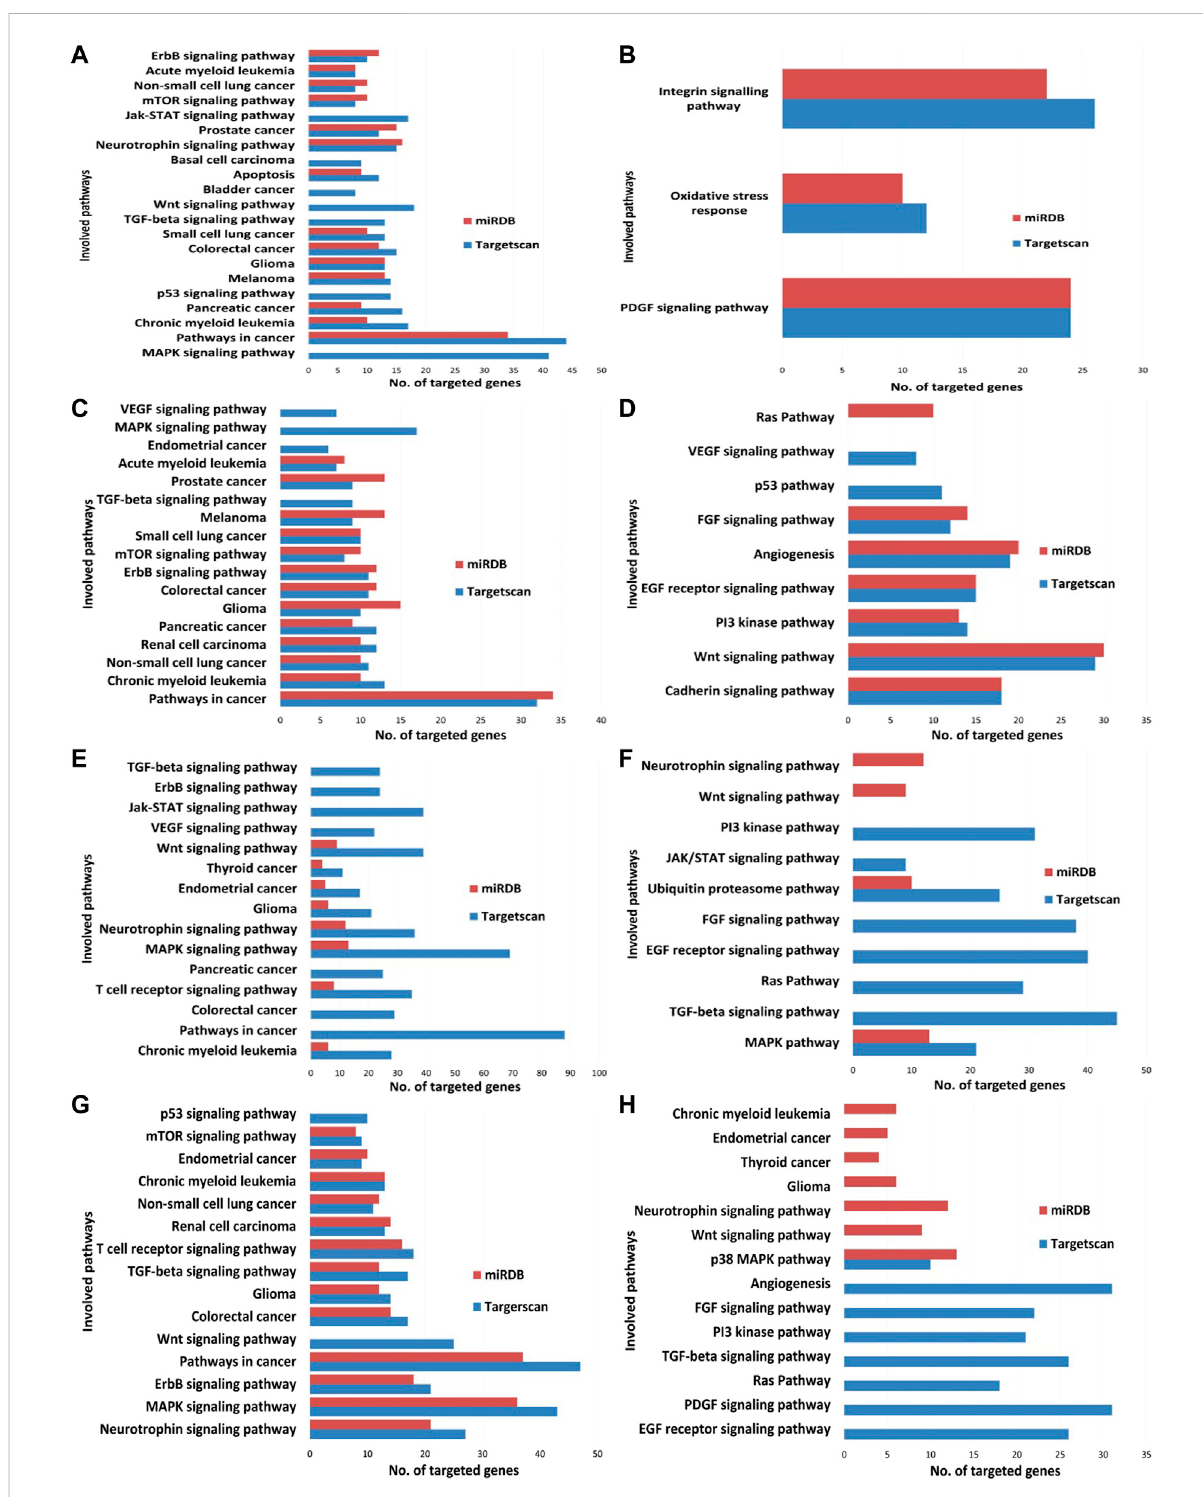
FIGURE 13 microRNAtargetvalidationenrichmentdatafromKEGGandPANTHERdatabase. (A) Analysisofhas-let7e-5pfromKEGGpathwaydatabase; (B) analysis of has-let7e-5p from PANTHER pathway database; (C) analysis of has-miR320a from KEGG pathway database; (D) analysis of has-miR320a fromPANTHERpathwaydatabase; (E) analysisofhas-miR21-3pfromKEGGpathwaydatabase; (F) analysisofhas-miR21-3pfromPANTHERpathway database; (G) analysis of has-miR27a-3p from KEGG pathway database; (H) analysis of has-miR27a-3p from PANTHER pathway